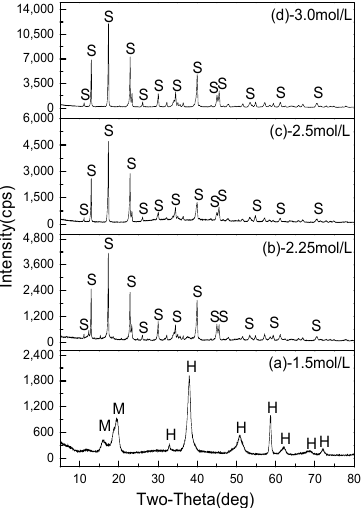
Figure 8. XRD patterns of whiskers obtained at different MgSO 4 concentrations H-Mg(OH) 2 , S-5Mg(OH) 2 ·MgSO 4 ·2H 2 O, M-MgSO 4 · x H 2 O.